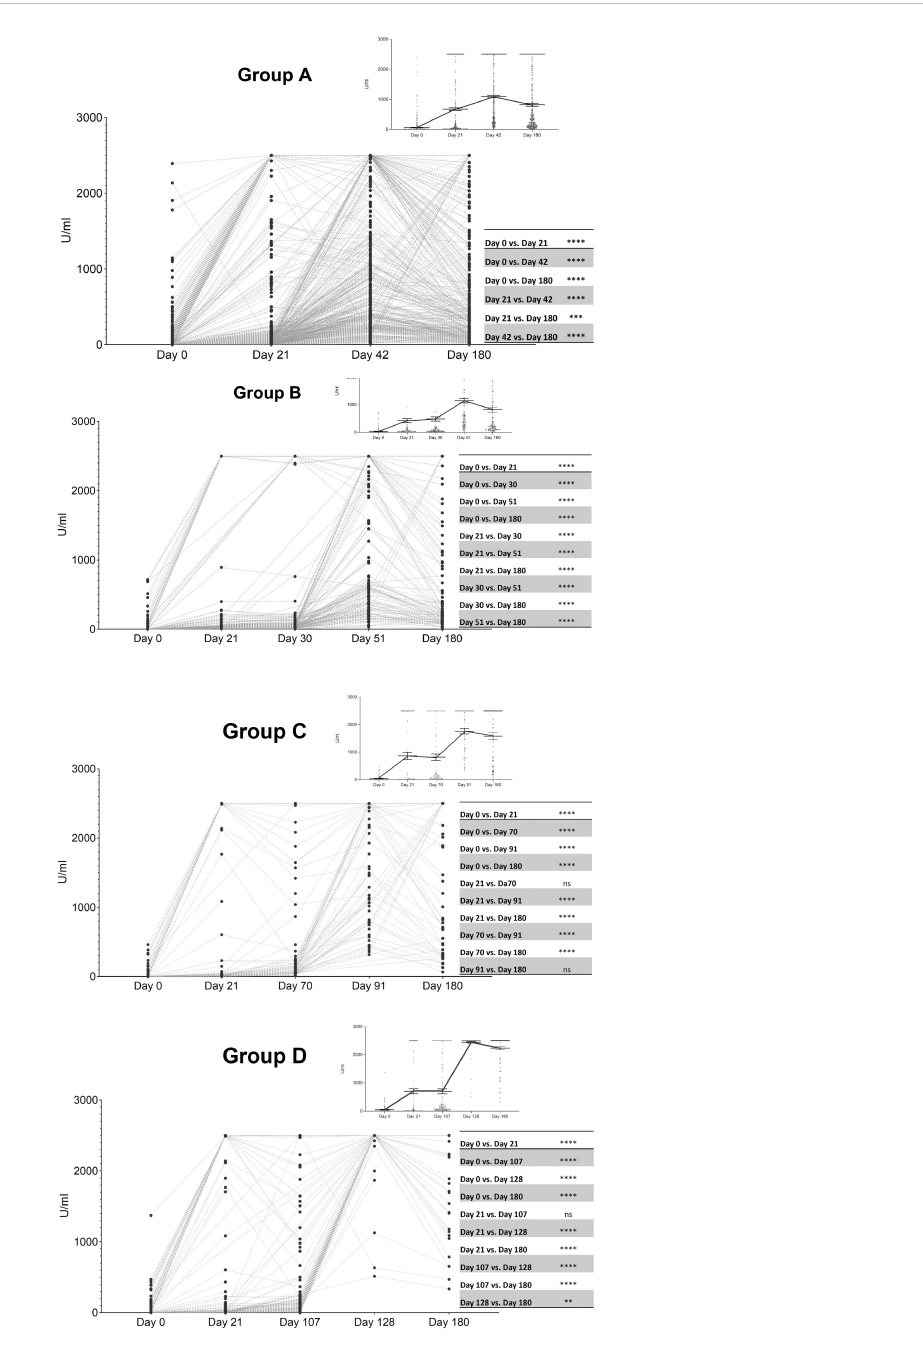
FIGURE 1 Levels of anti-S antibodies in the four groups of immunized subjects at different time point evaluations. T1: baseline values when administered the fi rst dose; T2: 21 days after the fi rst dose; T3: the time of the second dose; T4: 21 days after the second dose; T5: 180 days after the fi rst dose. Horizontal lines from the top right panel indicate the mean ± standard error of the mean whereas points represent individual data. Grey lines connect paired individual data Friedman test and Dunn´s test for multiple comparison analysis; **, p <.01; ***, p <.001; ****, p <.0001. Group A (two doses of the Sputnik vaccine separated by a 21-day interval): Day 0 (T1) signi fi cantly different from the remaining time point evaluations ****, Day 21 (T3) signi fi cantly different from Day 42 (T4) (****) and Day 180 (T5) (***), Day 42 (T4) statistically different from Day 180 (T5) (****). Group B (two doses of the Sputnik vaccine separated by a 30-day interval): Day 0 (T1) signi fi cantly different from the remaining time point evaluations ****, Day 21 (T2) signi fi cantly different from Day 30 (T3) (****) Day 51 (T4) (****), and Day 180 (T5) (****), Day 30 (T3) statistically different from Day 51 (T4) (****) and Day 180 (T5) (****), Day 51 (T4) statistically different from Day 180 (T5) (****). Group C (two doses of the Sputnik vaccine separated by a 70-day interval): Day 0 (T1) signi fi cantly different from the remaining time point evaluations ****, Day 21 (T2) signi fi cantly different from Day 91 (T4) (****), and Day 180 (T5) (****), Day 70 (T3) statistically different from Day 91 (T4) and Day 180 (T5) (****). Group D (First dose of the Sputnik vaccine, followed by a second dose of Moderna vaccine separated by a 107-day interval): Day 0 (T1) signi fi cantly different from the remaining time point evaluations ****, Day 21 (T2) signi fi cantly different from Day 128 (T4) (****), and Day 180 (T5) (****), Day 107 (T3) statistically different from Day 128 (T4) (****) and Day 180 (T5) (****). Day 128 (T4) statistically different from Day 180 (T5)